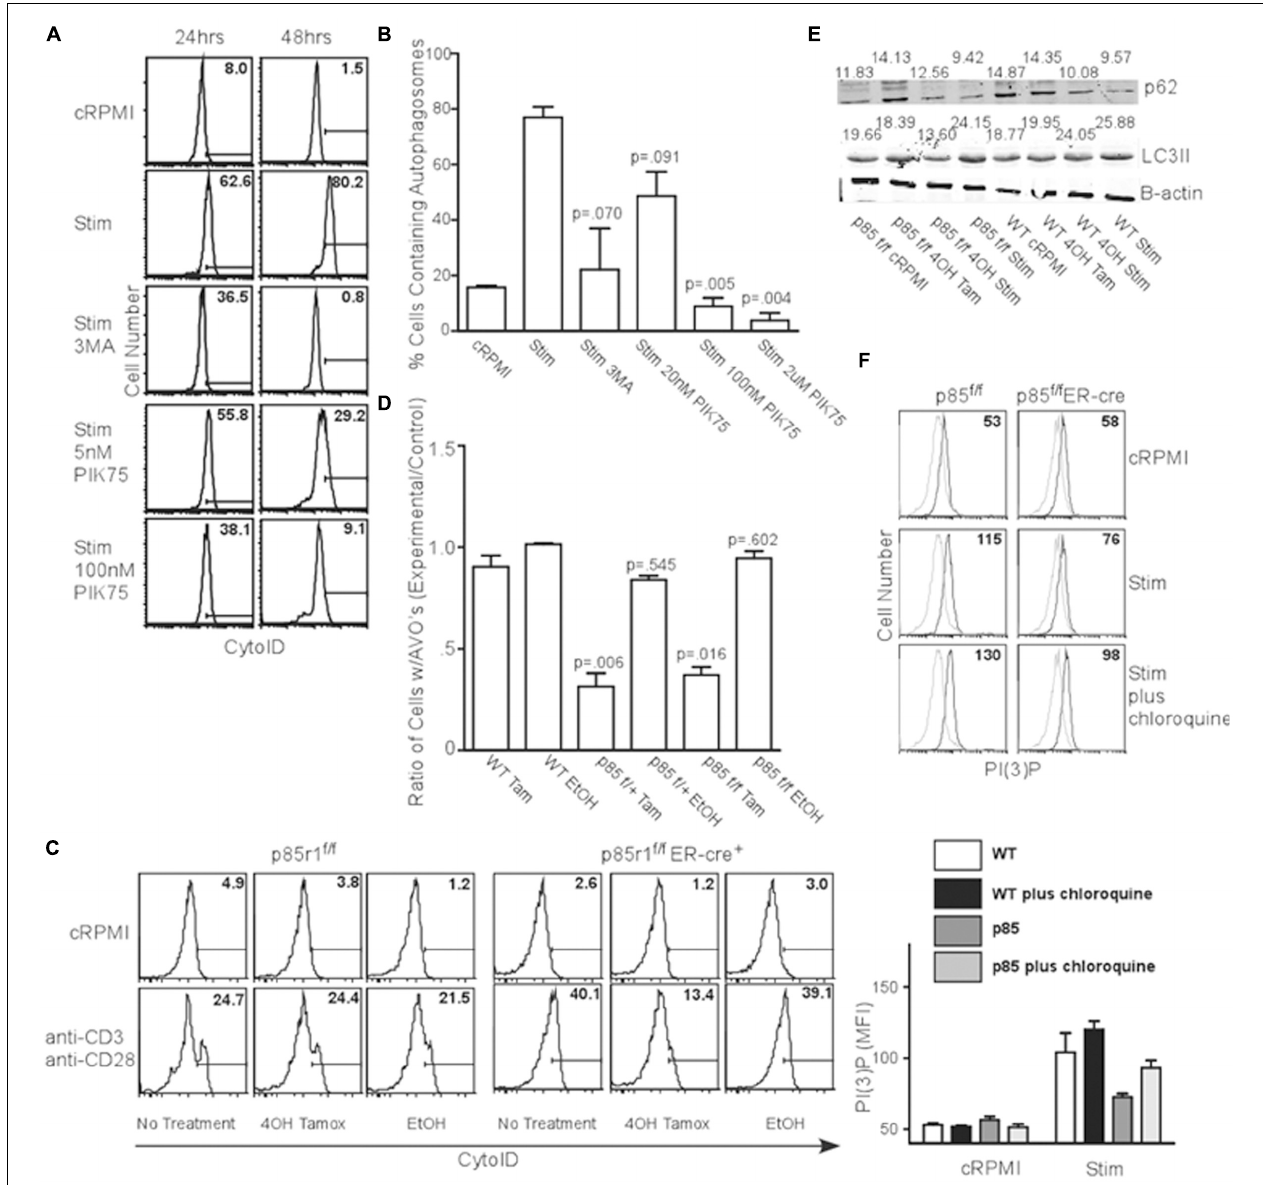
FIGURE 2 | TCR-induced autophagy is dependent upon class I PI3K and 5 (cid:48) phosphatase activity. (A) AVO formation histograms gated on live CD4 T lymphocytes stimulated with 1ug/mL soluble anti-CD3 and anti-CD28 for 24 and 48 h with the indicated reagents. A 5 mM 3MA, 100 nM PIK75, and 2 µ M PIK75 potently reduced AVO formation, especially at 48 h. Histograms are representative of at least 3 independent experiments under each condition. (B) Quantitation of AVO formation from (A) summarizing at least 3 independent experiments per condition. (C) AVO formation in p85 f / f and p85 f / f ER-cre CD4 T cells demonstrates the requirement for class I PI3K in TCR-mediated autophagy induction. Splenocyte and lymphocyte mixtures were cultured for 4 days in 1 ng/mL IL-7 and either 500 nM 4OH Tamoxifen or EtOH, and stimulated for 2 days with 1 µ g/mL soluble anti-CD3 and anti-CD28 for 48 h. (D) Quantification of (C) . Ratios of AVO formation of CD4 T cells pre-treated with 4OH Tamoxifen or EtOH to those kept in complete media for 96 h. Data are compiled from 3 independent experiments. (E) p62 degradation and LC3 lipidation are impaired in p85-deficient CD4 T cells. Cells were treated as in (C) . Numbers indicate band densities compared to those of β -actin. (F) PI(3)P levels measured 24 h after activation through soluble anti-CD3 and anti-CD28 as in (C)